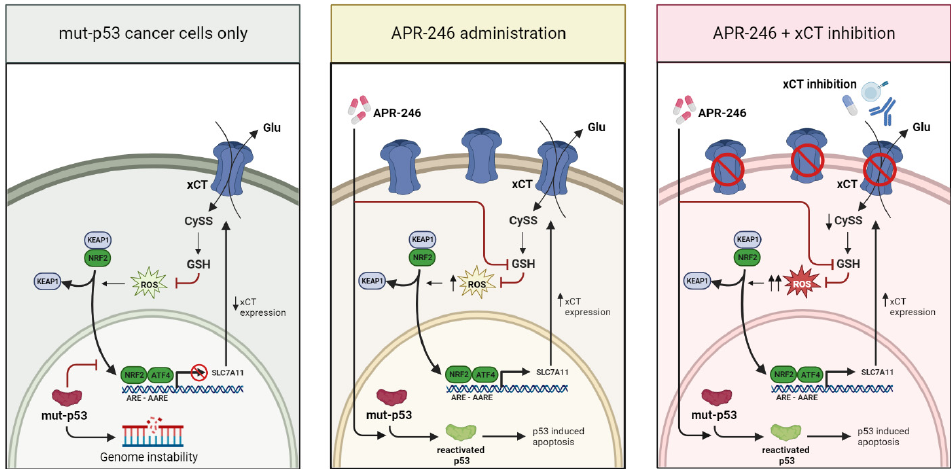
Figure 7. Schematic representation of xCT and mut-p53 interplay in presence or absence of APR- 246 treatment. Left panel: p53-induced modification in mut-p53 cancer cells; central panel: alterations induced by APR-246 administration include the restoring of xCT expression and the inhibition of GSH; right panel: cellular alteration induced by the combination of APR-246 administration and xCT inhibition. Long black arrows: induction; red lines: inhibition; short black arrows up: xCT upregulation; short black arrows down: xCT downregulation; inhibited circle: loss of xCT expression.